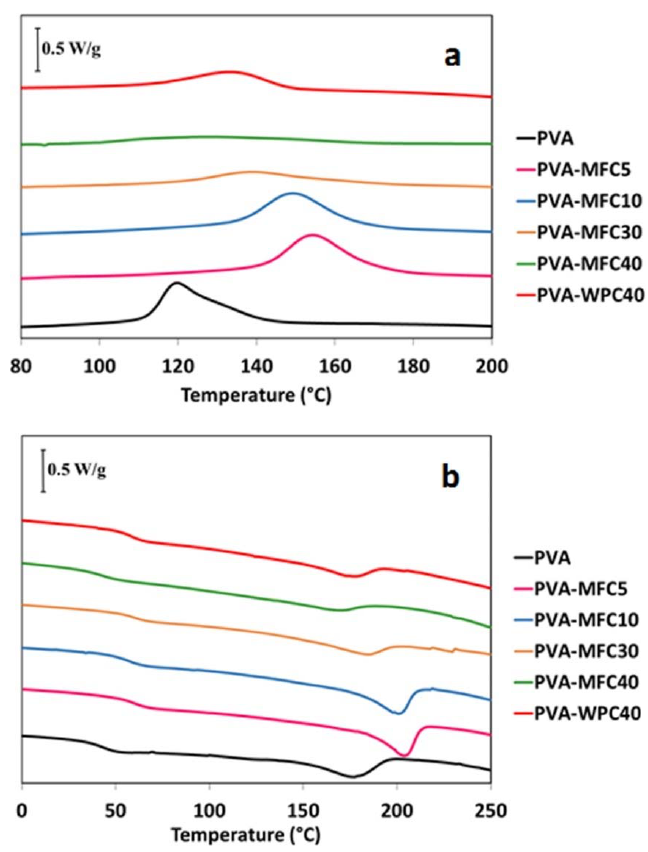
Figure 5. DSC curves of PVA-based foams. ( a ) cooling cycle, and ( b ) second heating cycle.